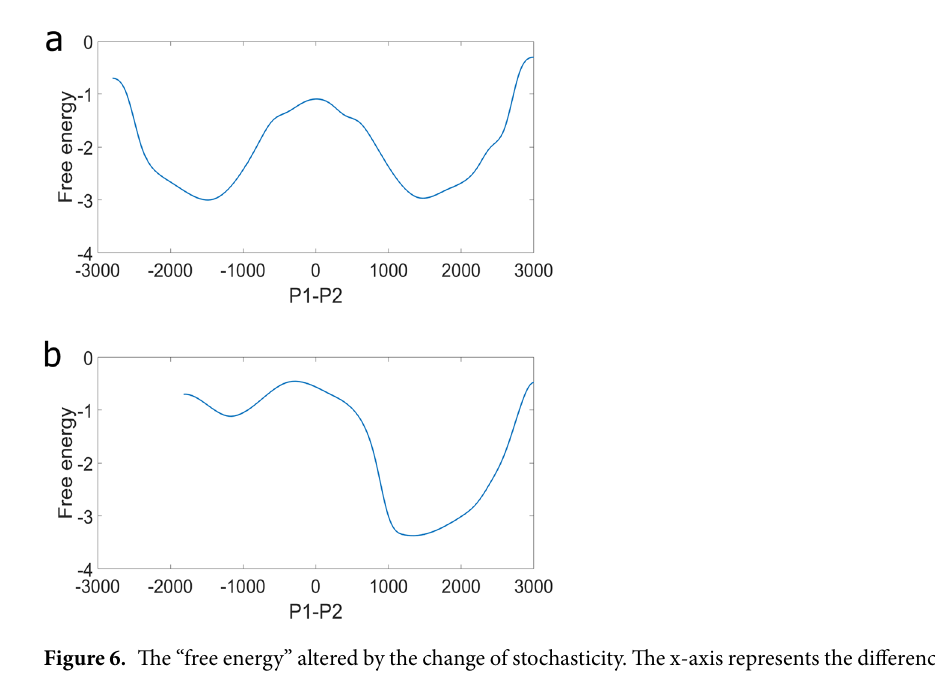
Figure 6. The “free energy” altered by the change of stochasticity. The x-axis represents the difference between P1 monomer and P2 monomer. For both sub-figures, the transcription rate constant of Y is of nominal value. ( a ) the transcription rate of gene X is of nominal value. ( b ) the transcription rate of gene X is 8 folds of the nominal value. The addition of inhibitor X lower the “free energy” of the right valley and raised that of the left valley; cells moved from left to right (which is from P1 OFF to P1